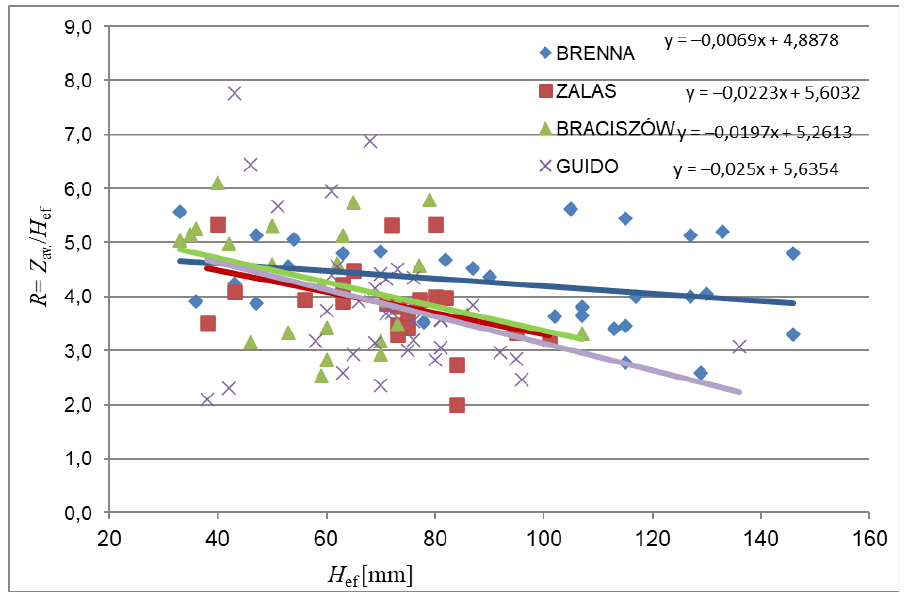
for different rock types. ef